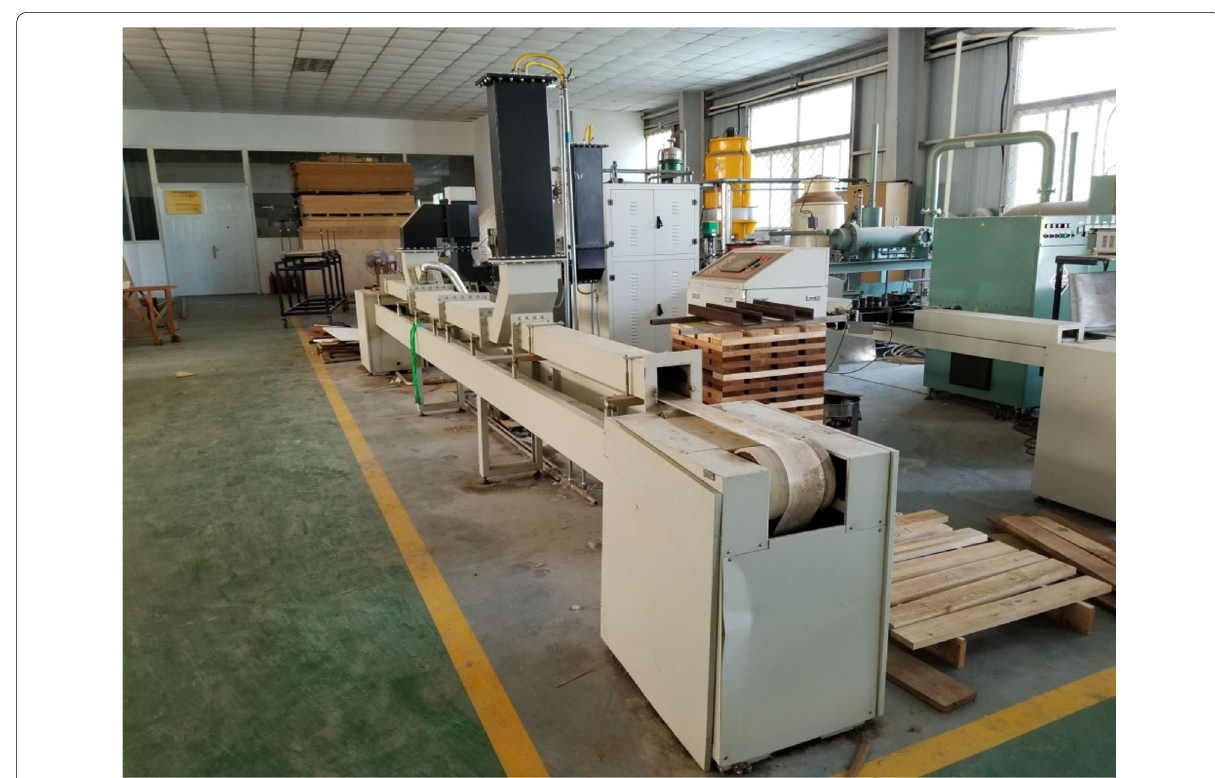
Fig. 1 WX20L-19 continuous feeding MW equipment